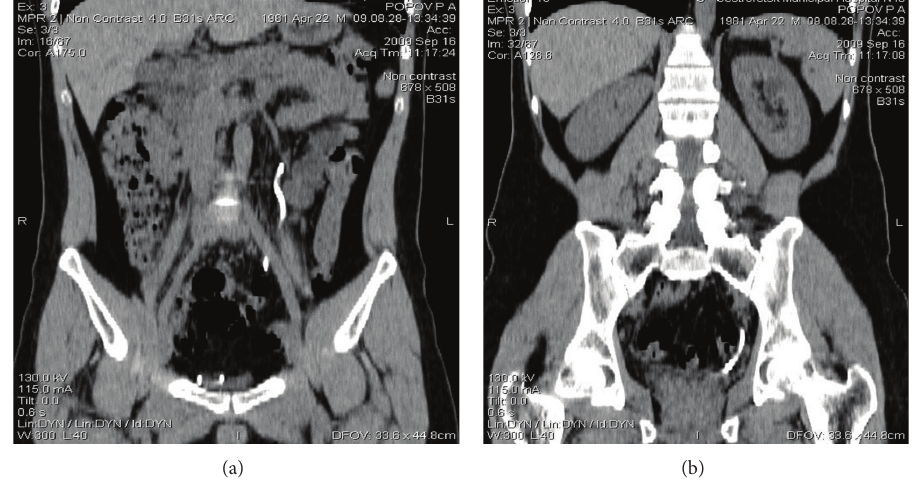
Figure 4: Control CT (3 weeks after stenting and immediately after stent removal)—no extravasation of the contrast medium.